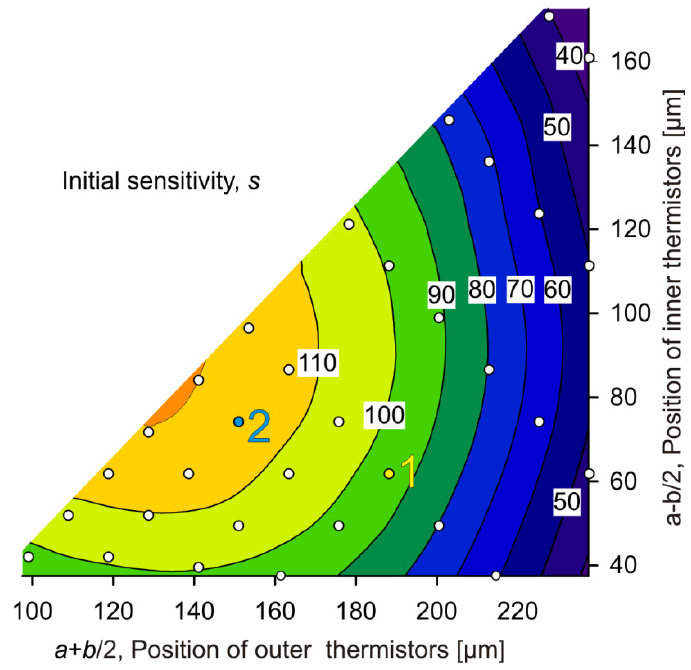
Figure 13. Contour plot of the initial flow sensitivity s (mV · s/m) of the bridge detuning voltage as a function of the thermistor